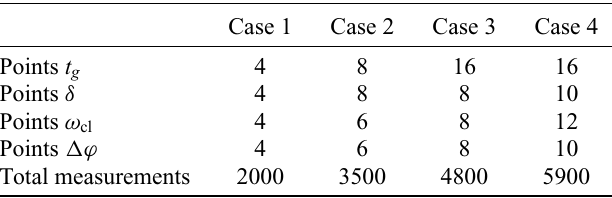
TABLE I. Number of points used in the scans for the different cases for a 1D parameter scan tuneup considered. Case 1